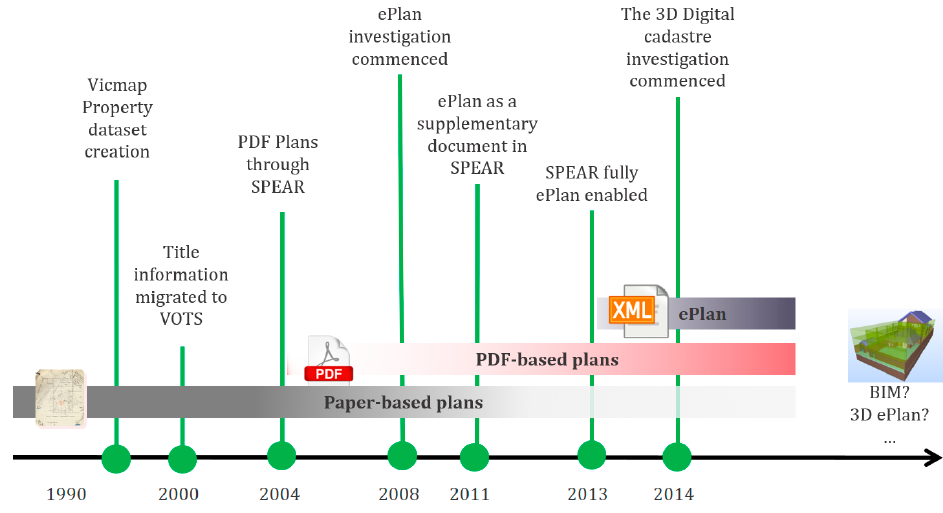
Figure 1. Victorian cadastral information (paper → digital).